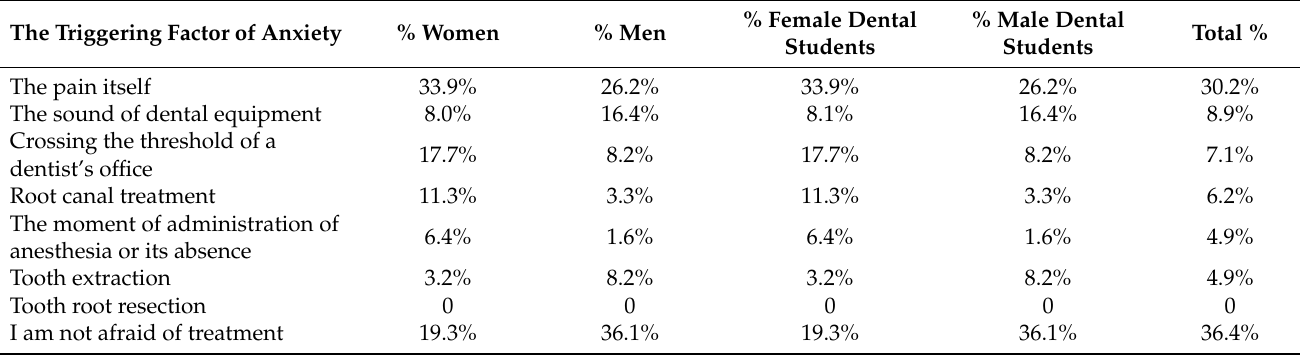
Table 5. Patient fears related to dental treatment.